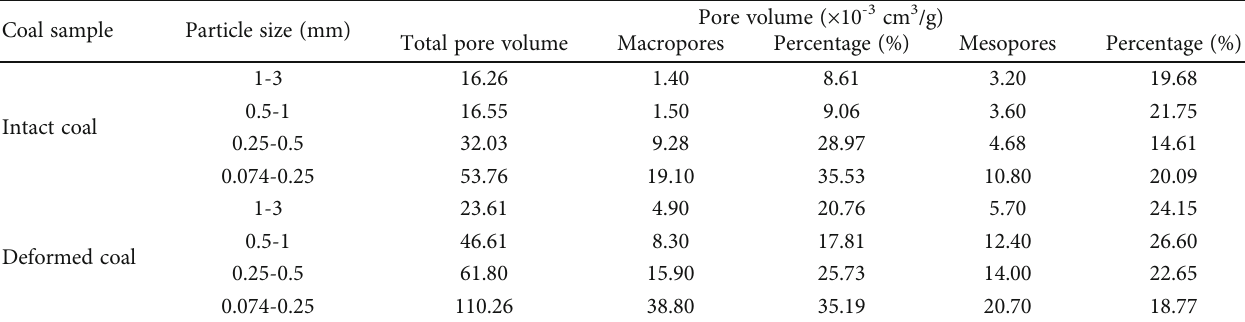
Table 2: Pore structure characteristic parameters of macropores and mesopores.